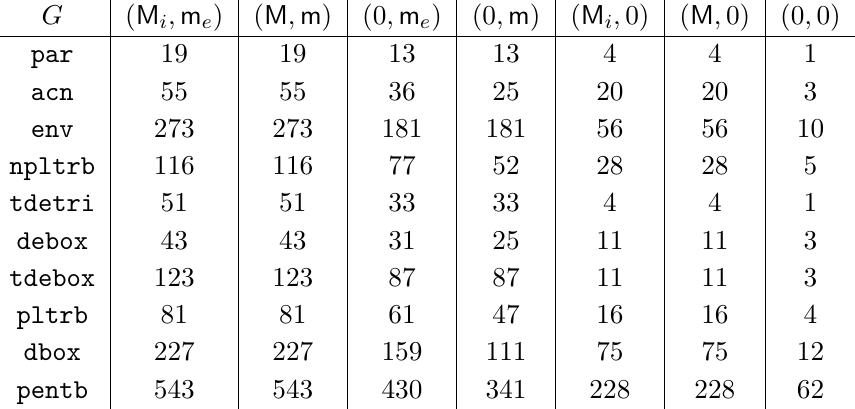
Table 3. Signed Euler characteristic | χ ( X G ) | computed using the numerical code from section 5.2 for diagrams G from figure 1; see Ex.